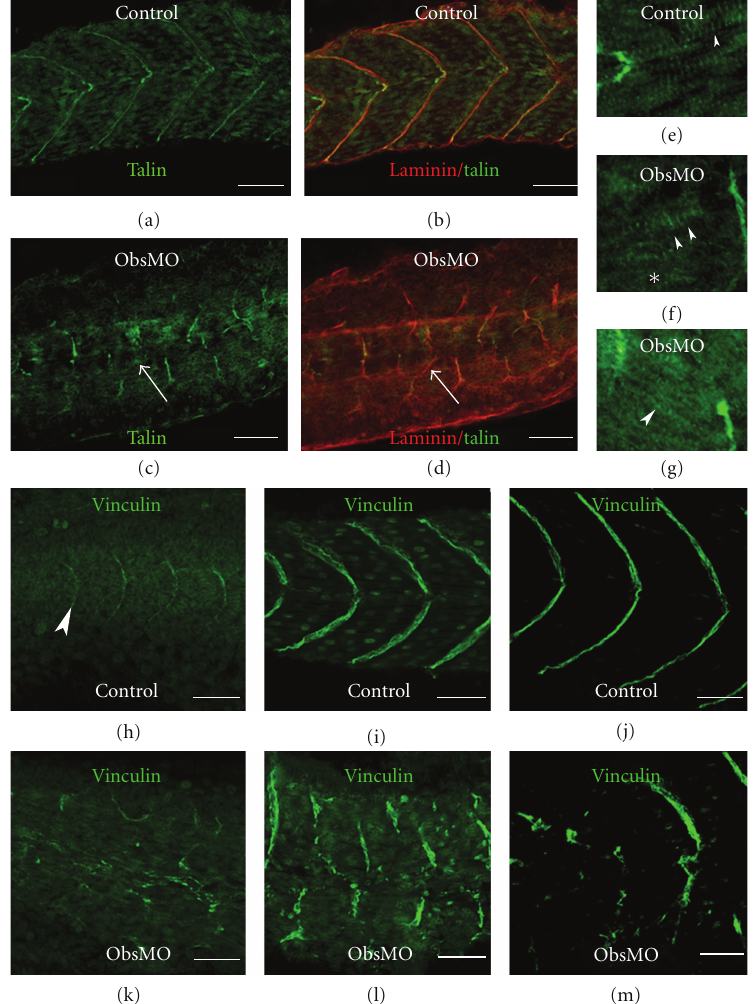
Figure 6: Overlapping localization of talin and vinculin during early skeletal muscle development. Control (a), (b), (e), (h)–(j) and obscurin A morphant (c), (d), (f), (g), (k)–(m) embryos were immunostained for talin ((a)–(g): green) and laminin ((b), (d): red) or vinculin ((h)– (m): green) at 24 (a)–(h), (k), 48 (i), (l), or 72 (j), (m) hpf. (a) In a control embryo, talin localizes to the MTJ and overlying the myofibrils at 24hpf. (b) At the MTJ, talin localizes immediately adjacent to laminin. (c), (d) In obscurin A morphant embryos at 24 hpf, talin does localize to the irregularly organized MTJs but there are regions in which laminin has been deposited where talin has not yet accumulated (arrow). (e), (f) In control and obscurin A morphant embryos, talin localizes overlying the Z disk (arrowheads) although there are regions of di ff use talin localization in the morphant (asterisk) that were not noted in the control. (g) In newly forming myofibrils talin localizes along the myofibril (arrowhead) before achieving a striated pattern overlying the Z disk. No talin localization was noted overlying the mid-A-band. (h), (k) Like talin, vinculin localized to the somite boundary/MTJ ((h): arrowhead) at 24 hpf in both control (h) and morphant (k) embryos. (i), (l), (j), (m) By 48hpf, there is progressive accumulation of vinculin at the MTJ in control (i) and morphant (l) embryos with nearly exclusive localization to the MTJ by 72 hpf in both control (j) and morphant (m) embryos. Scale bars are 50 μ m. Panels (e)–(g) are 3x magnifications of the corresponding regions of (a), (c), and